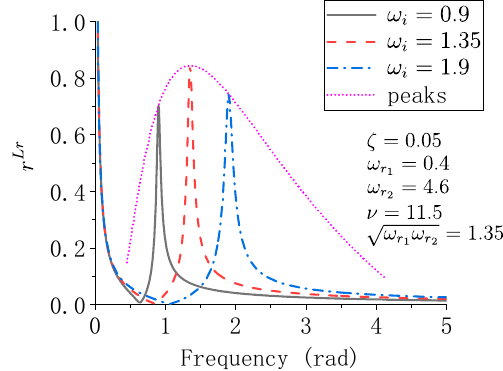
Figure 2. Examples of Lr r for a particular parameter setting.